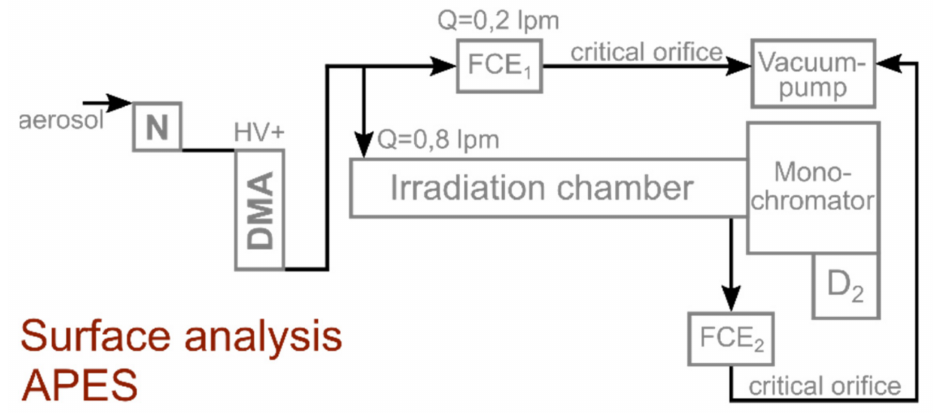
Figure 2. Detailed setup of APES. The spectral dispersion of the monochromatic light is 4.04 nm ± 0.13 nm from 190 nm to 320 nm. The standard deviation of eWF determination is in the range of ± 0.02 eV and is highly reproducible. N: Soft X-ray neutralizer, DMA: Differential mobility analyzer, FCE: Faraday cup electrometer, D 2 : Deuterium